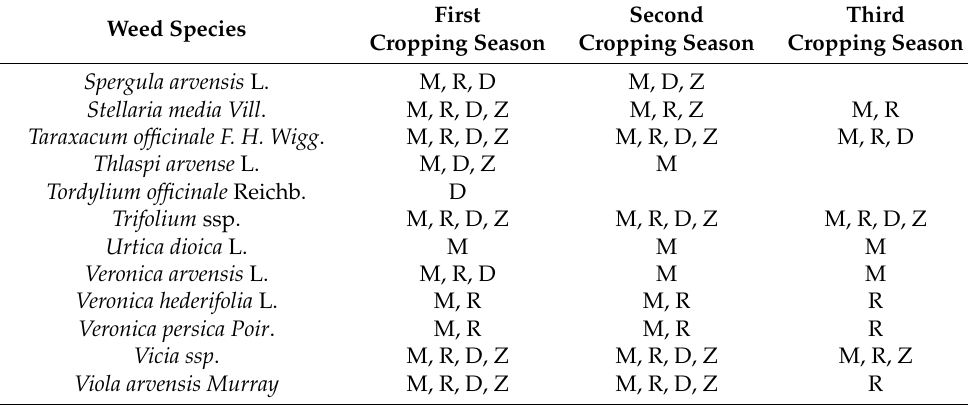
First Second Cropping Season Cropping Season